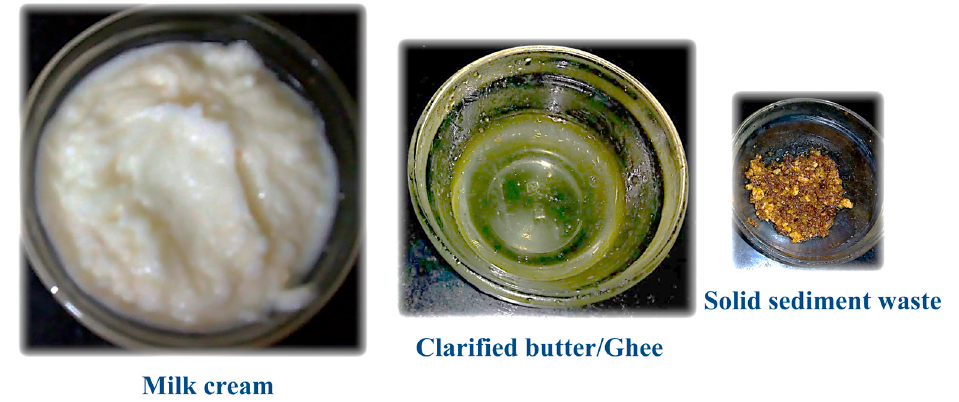
Figure 2. Production of clarified butter from milk cream; a charred (brunt) light-to-dark-brown solid sediment was obtained during the clarification process.